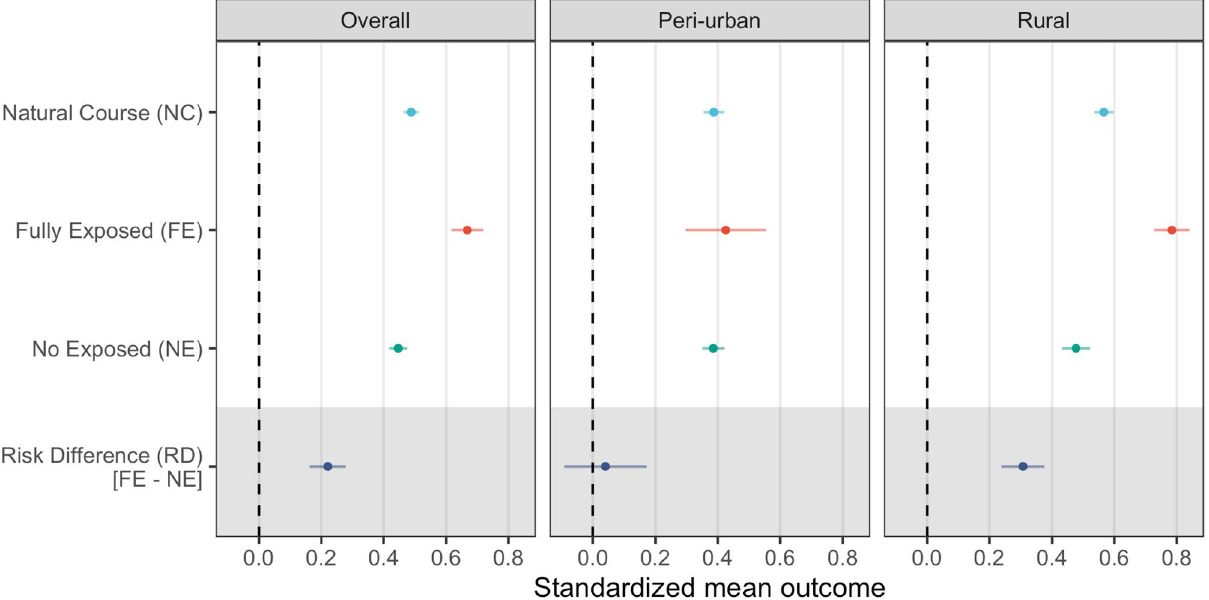
Figure 2. Summary of g-computation estimates by geographic area in the Loreto department in the Peruvian Amazon. Standardized mean outcome estimations for the natural course (NC) and simulated scenarios of full exposure (FE), no exposure (NE) and their risk differences (RD, grey